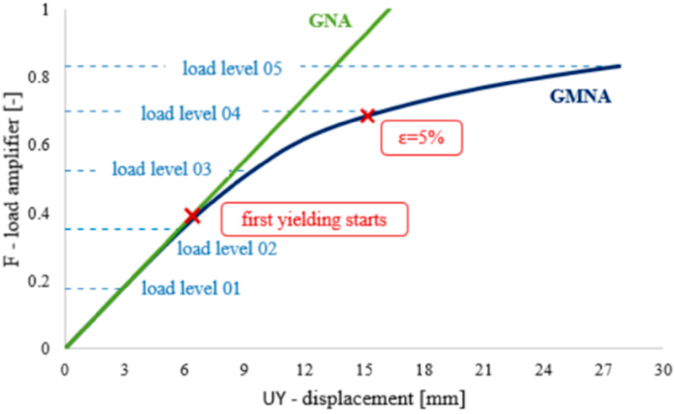
Figure 12. Load levels plotted on the load–displacement diagram.